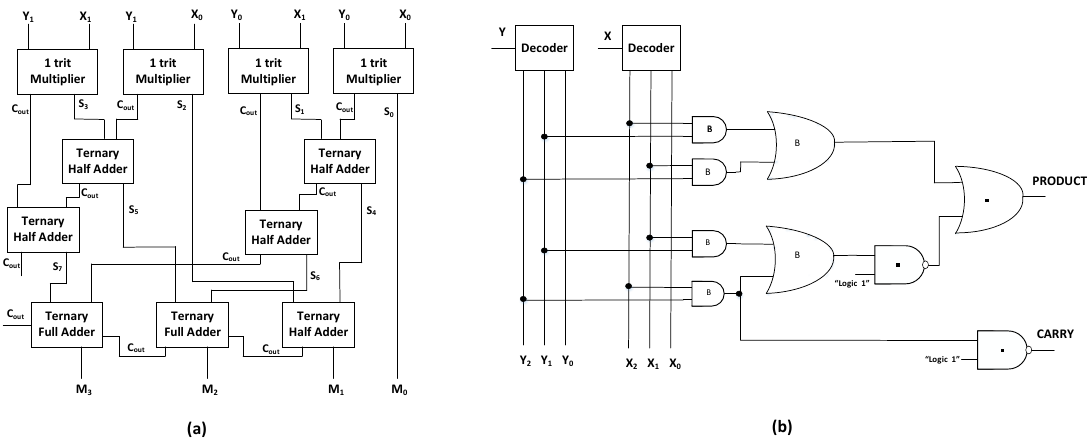
Figure 11. ( a ) Block diagram of 2-trit multiplier [49]. ( b ) Circuit schematic of 1-trit CNTFET-RRAM ternary multiplier